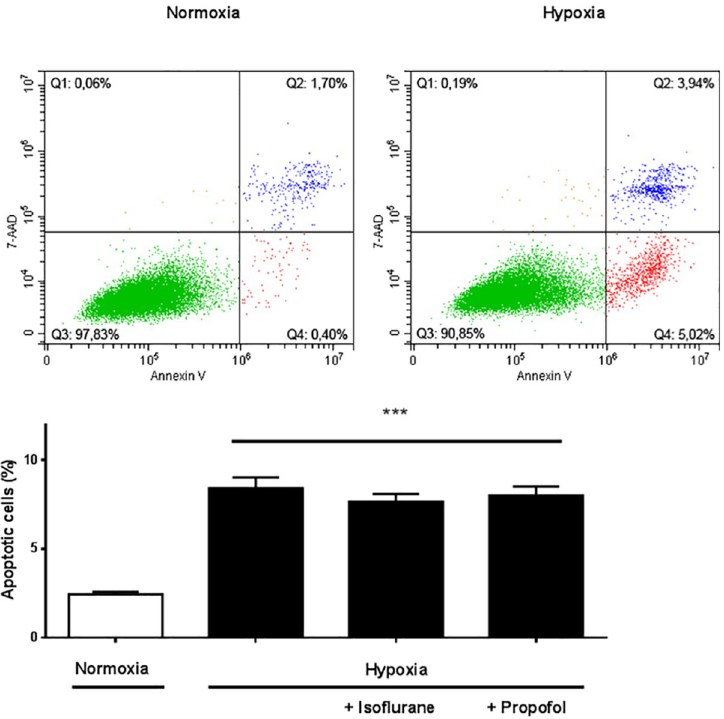
Fig 5. A effect of normoxia/hypoxia exposure on apoptosis rate of H9c2 cells. Representative flow cytometric images after 18 hours of normoxia or hypoxia without incubation with EVs. Apoptosis was detected by Annexin V/ 7-AAD staining. b Quantitative analysis of apoptotic cells after normoxia/hypoxia and isoflurane or propofol exposure. Apoptosis was markedly increased by hypoxia, whereas isoflurane or propofol had no significant additional beneficial effect. Results are expressed as means ± SEM; n = 10 ( ��� p < 0.0001).